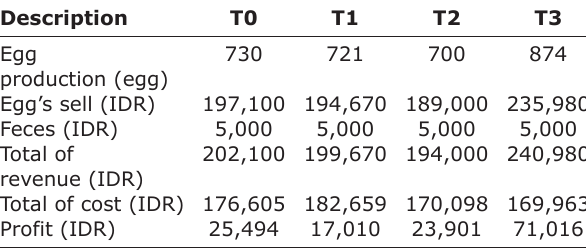
Table-6: Total of revenue and profit each